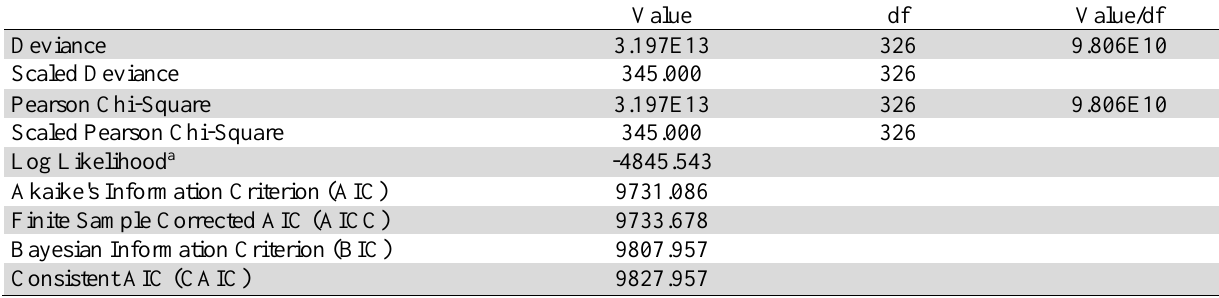
The summary of statistics of fitness